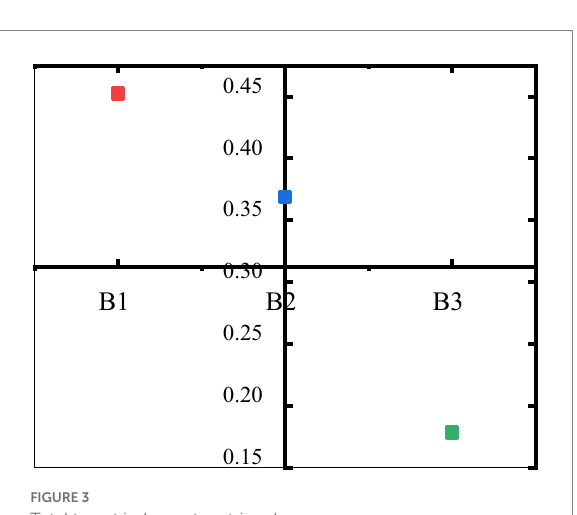
FIGURE 3 Total target judgment matrix